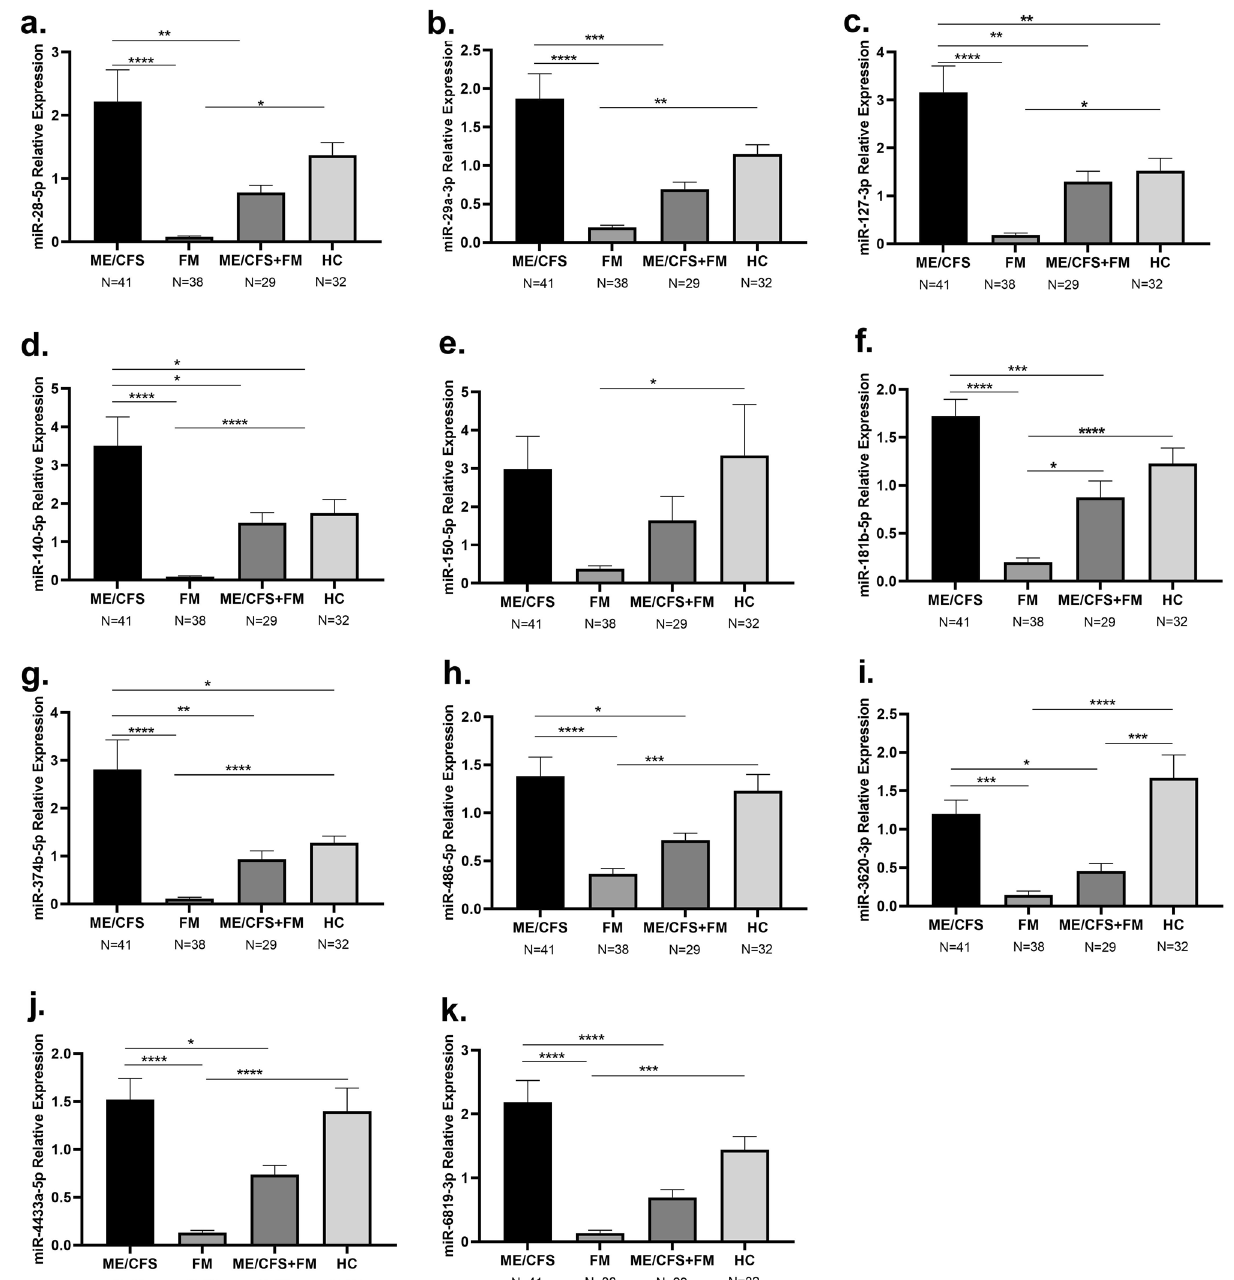
Figure 2. Relative expression of circulating miRNAs in individuals with ME/CFS, FM, ME/CFS + FM and HC. Displayed in the graphs are the mean and ± standard error of the mean of ( a ) hsa-miR-28-5p ( b ) hsa-miR- 29a-3p ( c ) hsa-miR-127-3p ( d ) hsa-miR-140-5p ( e ) hsa-miR-150-5p ( f ) hsa-miR-181b-5p ( g ) hsa-miR-374b-5p ( h ) hsa-miR-486-5p ( i ) hsa-miR-3620-3p ( j ) hsa-miR-4433a-5p ( k ) hsa-miR-6819-3p. One-way ANOVA followed by Tukey’s multiple comparisons test were performed to determine the significant difference in the miRNA expression between the groups. Results were considered significant at *P value < 0.05, **P value < 0.01, ***P value < 0.001, ****P value < Among the 11 miRNAs, miR-127-3p, miR-140-5p and miR-374b-5p were over-expressed in ME/CFS and under- expressed in FM. These three miRNAs could be used as potential biomarkers to distinguish ME/CFS from FM. Using a machine-learning approach, RFM models integrating the differential expression signatures of 11 circulating miRNA were successfully developed to discriminate ME/CFS, FM, ME/CFS + FM and HC groups. However, the prediction model based of ME/CFS versus HC was not sensitive or specific enough for this task. This result is not surprising since we have previously demonstrated a prediction model based on the differential